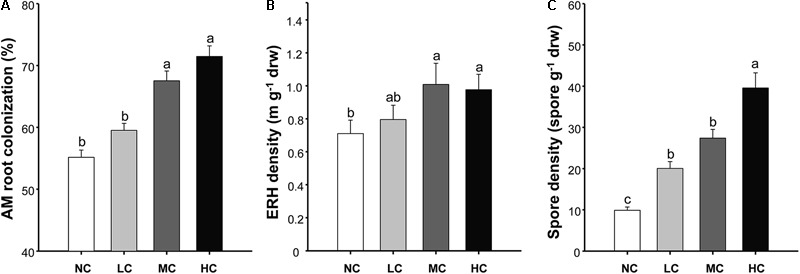
Arbuscular mycorrhizal (AM) root colonization (A), extraradical hyphal (ERH) density (B), and spore density (C) among treatments. NC, control; LC, low level of compost addition; MC, moderate level of compost addition; HC, high level of compost addition. Bars are SEMs (n = 12). Shared letters above bars denote no significant difference among treatments, as indicated by Tukey’s HSD test at p < 0.05.